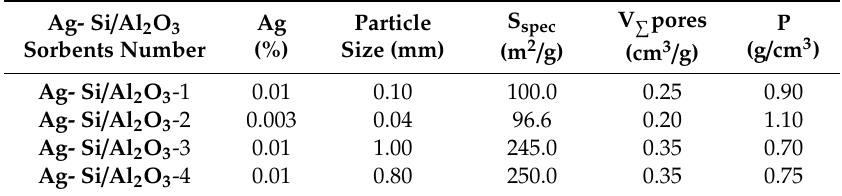
Table 2. Physico-chemical properties of Ag-Si / Al 2 O 3 sorbents (Based on [41]). Ag- Si / Al 2 O